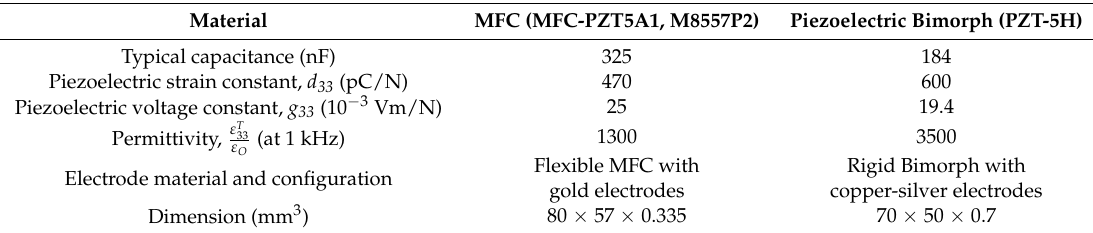
Table 1. The electromechanical properties of the harvester. MFC: microfiber composite. Material MFC (MFC-PZT5A1, M8557P2) Piezoelectric Bimorph (PZT-5H) Typical capacitance (nF) 325 184 Piezoelectric strain constant, d 33 (pC/N) 470 600 25 19.4 T Permittivity, ε (at 1 kHz) 1300 3500 33 ε O Flexible MFC with Rigid Bimorph with Electrode material and configuration gold electrodes copper-silver electrodes Dimension (mm 3 ) 80 × 57 × 0.335 70 × 50 × 0.7